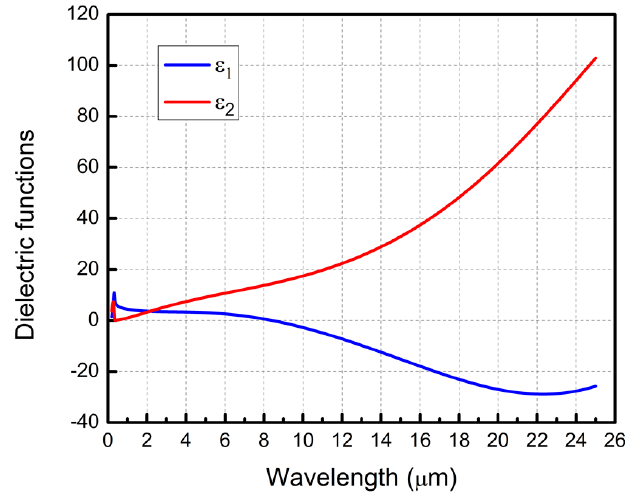
Figure 3. Experimental dielectric functions of TiO 2 :Nb films on silicon substrate. Real ( ε 1 ) and imaginary ( ε 2 ) parts in blue and red curves, respectively.